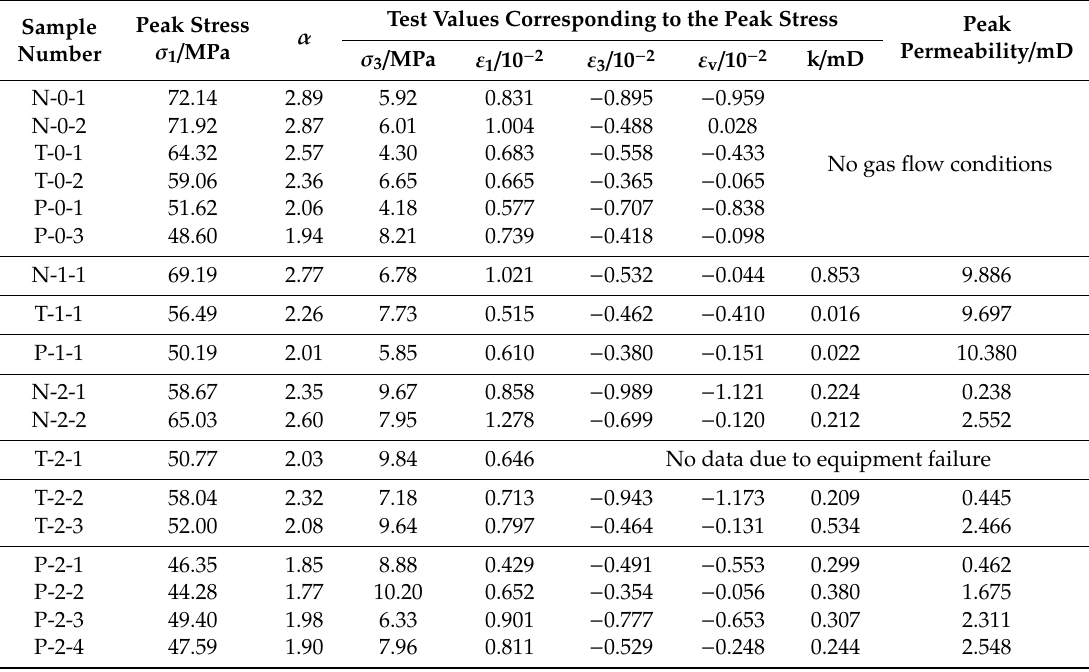
Figure 10. Peak stress and corresponding mechanical parameters under different mining-induced stress conditions: ( a ) peak stress and the corresponding confining pressure; ( b ) peak stress and the corresponding axial strain; ( c ) peak stress and the corresponding circumferential strain; ( d ) peak stress and the volumetric strain. Table 4. The test results of coal under di ff erent mining-induced stress